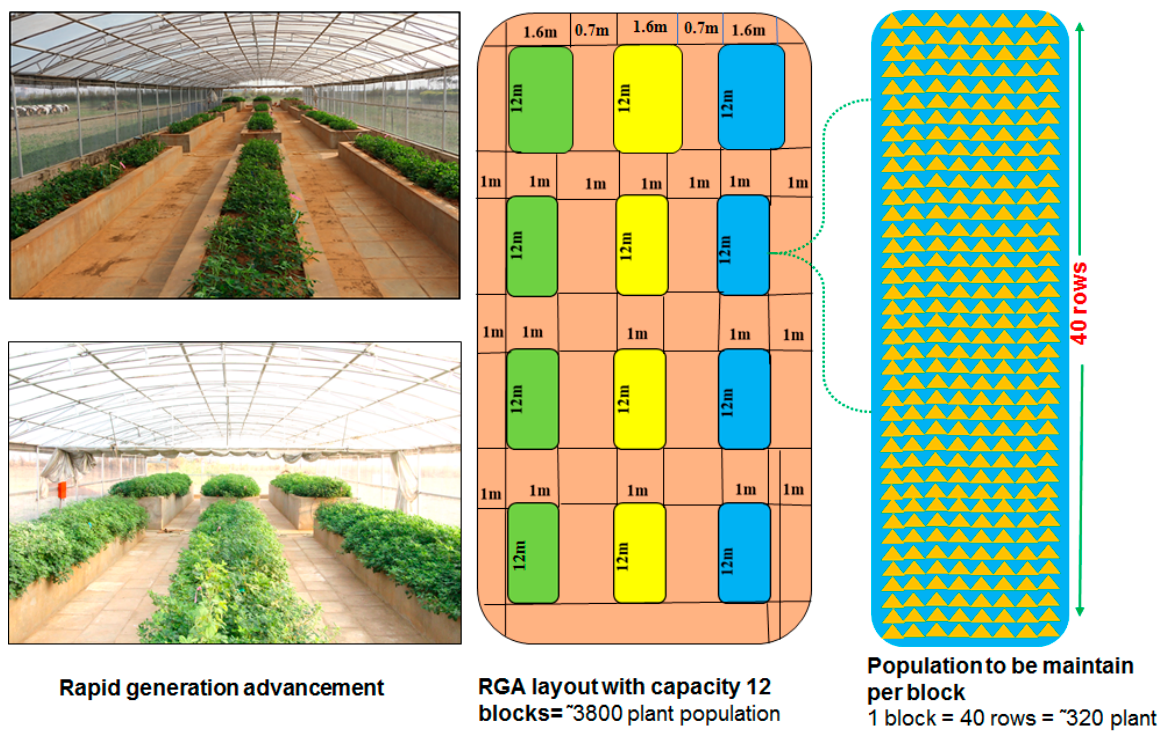
Figure 4. Rapid generation advancement (RGA) facility at ICRISAT for taking 3.5 generations per year.